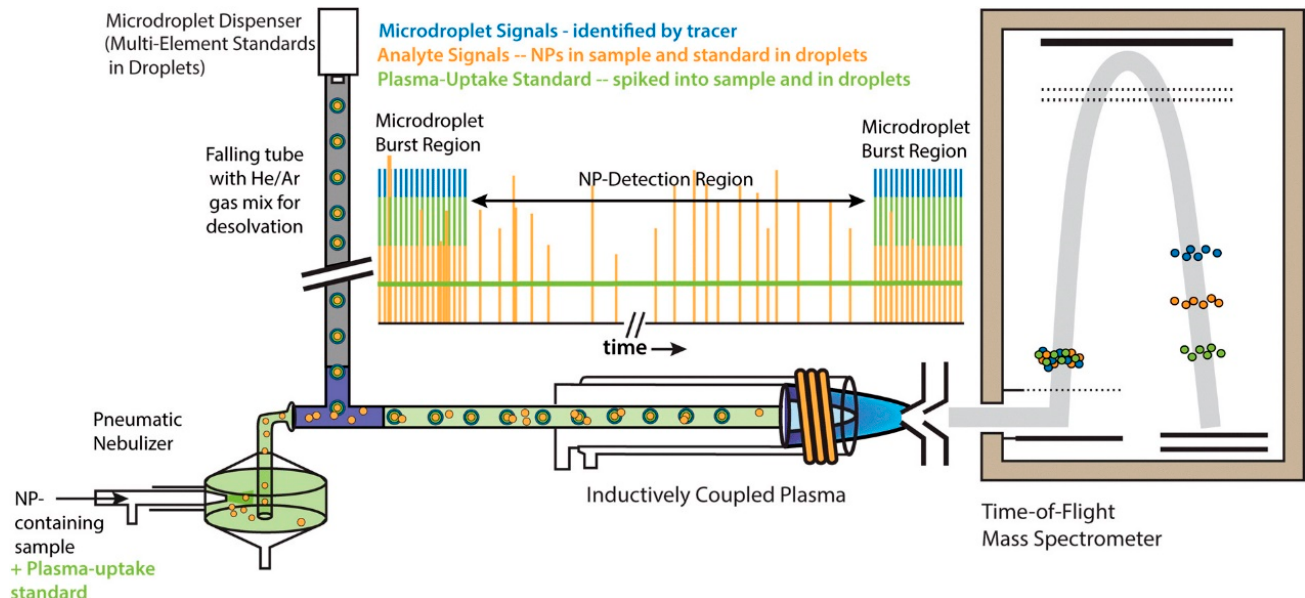
Figure 1. Schematic diagram of the online microdroplet calibration approach. Microdroplets com- posed of multi-element solutions are introduced into the ICP to provide absolute sensitivities (counts ∙ g − 1 ) for the calibration of NP mass. The droplet signals are measured in the “Microdroplet Burst Regions” of the TOF time trace. At the same time, NP-containing samples are introduced into the ICP via conventional pneumatic nebulization. NP signals are analyzed from the “sp-Region” of the TOF time trace, which typically lasts a few minutes in duration. Through the addition of a known amount of plasma uptake standard to both nebulized samples and microdroplet standards, the plasma uptake rate is determined in each analysis, which is then used to calibrate the PNC. The plasma uptake standard is usually Cs (Reprint with permission from Kamyar M. Environ. Sci.: Nano. 2019, 6, 3349–3358. Copyright 2019, Royal Society of Chemistry